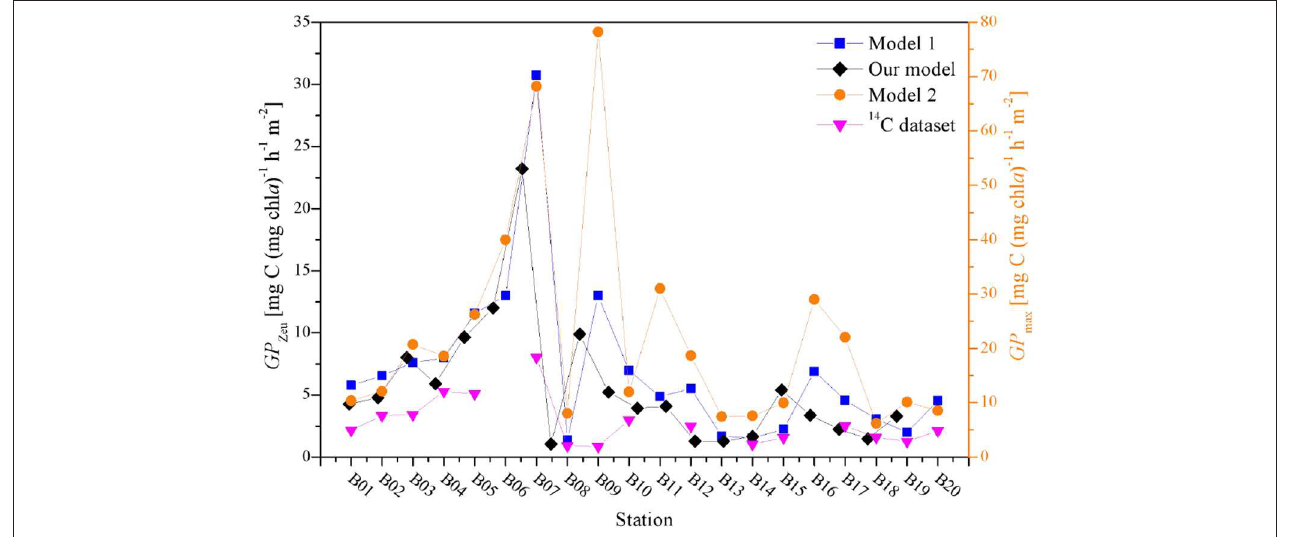
FIGURE 9 | A comparison among the water column integrated primary production from different FRRF approaches and synchronized 14 C